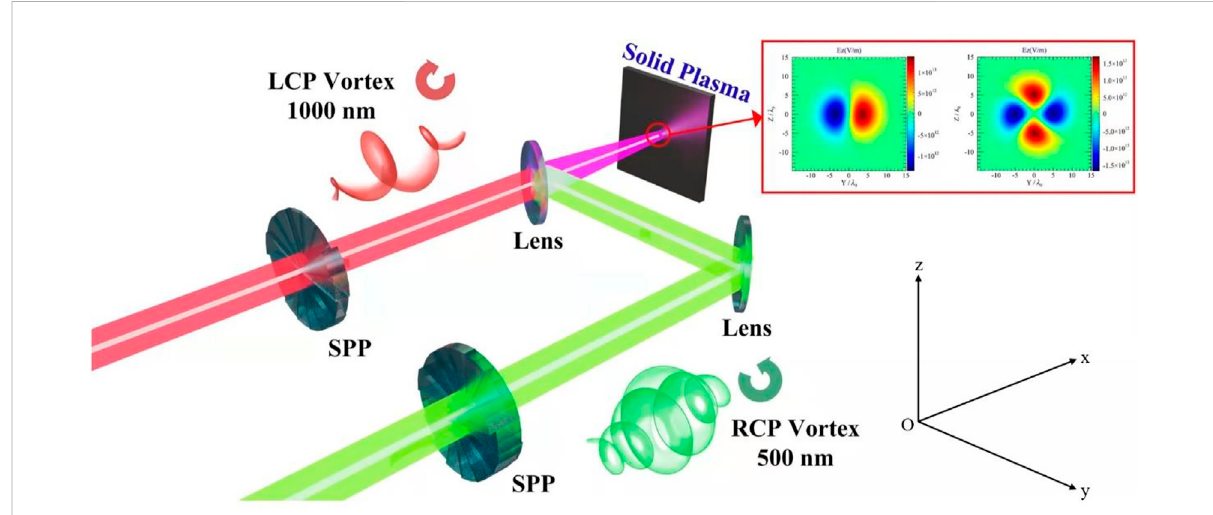
FIGURE 1 The sketch of the two-color counter-rotating LG laser scheme: dichromatic counter-rotating CP twisted laser pulses are spatiotemporally overlapped and normally irradiate the solid target to drive the laser-plasma HHG process (The SPP represent spatial phase plate, the LCP and RCP representleft-andright-CPlaserrespectivelyandtheinsetshowstheenlargedviewofthevortex modesofthefundamentalandsecond-harmonic driving pulses).